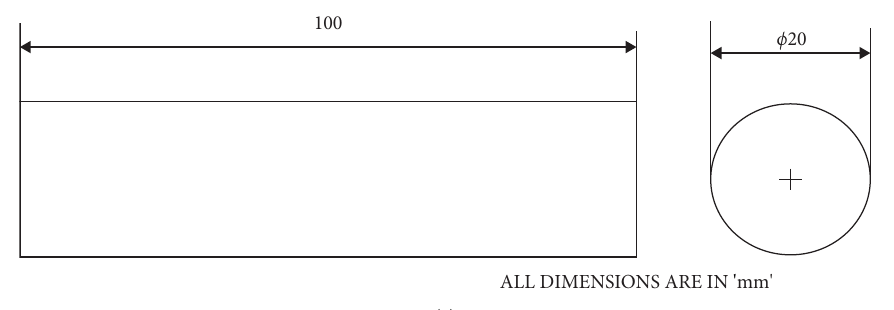
ALL DIMENSIONS ARE IN ' (a) Figure 4: